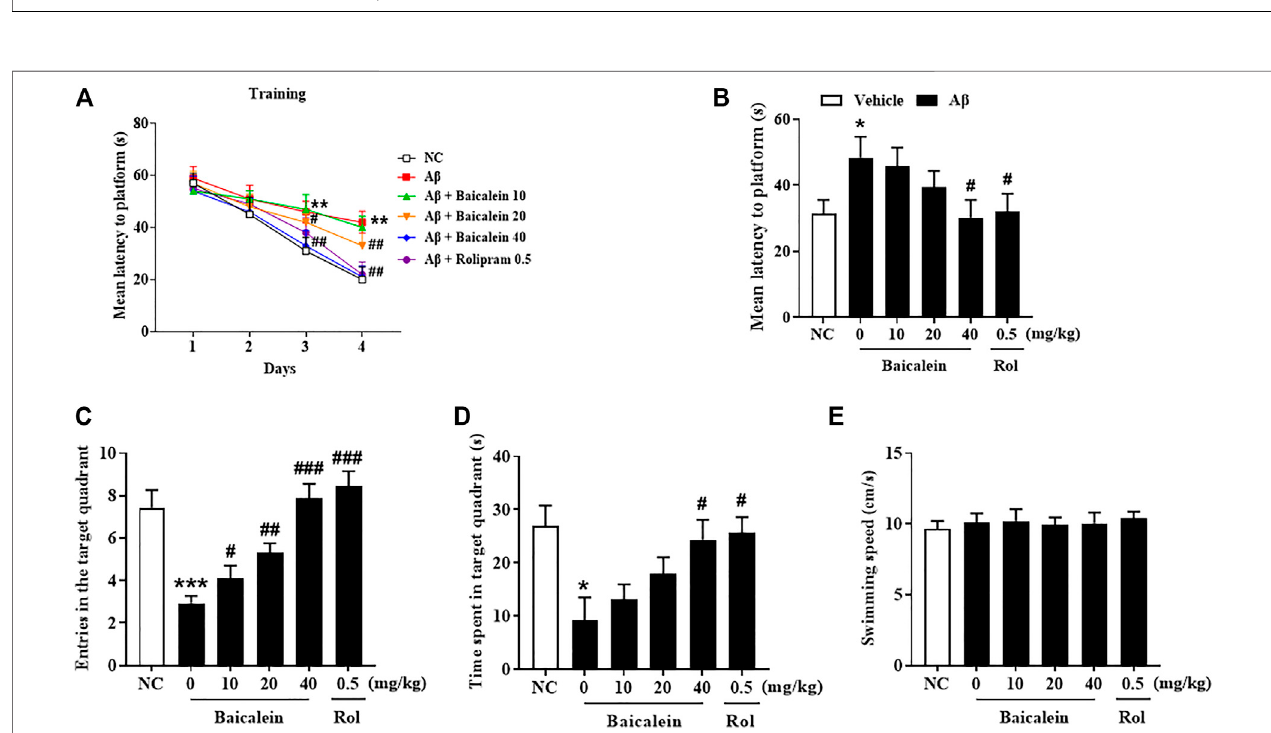
FIGURE3 | Baicalein improved memoryacquisitionand retention ofA β -treated mice in theMorris watermaze test. (A) Thelearningcurvein theMWM test, (B) the meanlatencytotheplatform, (C) thefrequencyofenteringthetargetquadrant, (D) durationoftimespentinthetargetquadrant,and (E) swimmingspeedwereimproved by baicalein treatment inA β -treated mice. Allvalueswere expressed asmean ± SEM( n (cid:2) 6). * p < 0.05, ** p < 0.01,*** p < 0.001 vs. NC mice; # p < 0.05, ## p < 0.01, ## p < 0.001 vs. A β -treated mice.